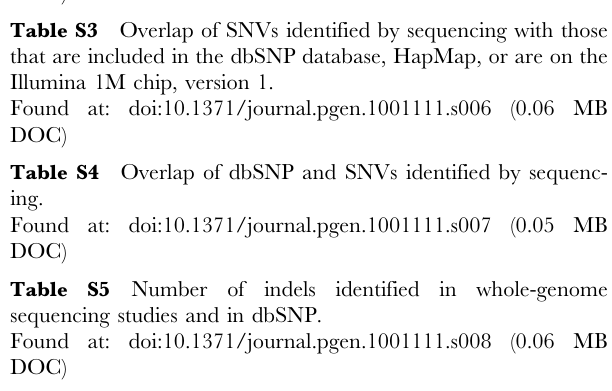
Figure S2 Position of protein truncating variants within coding sequences. These graphs show the relative locations of stop-gain SNVs (A) and frameshift indels (B) within protein-coding sequences. A relative location near 0.1 (left side of x-axis) indicates that the variant is near the N-terminus, while a location near 1.0 (right side of x-axis) indicates that the variant is near the C- terminus. The y-axis is the absolute count of variants. Figures include both homozygous and heterozygous variants from across all 20 genomes. Figure S3 F8 variants. This image shows the positions of the F8 variants that were observed in our dataset. Image modified from Ge et al. and Hubbard et al. Table S1 General characteristics for each genome. Table S2 Variants identified for each individual genome.